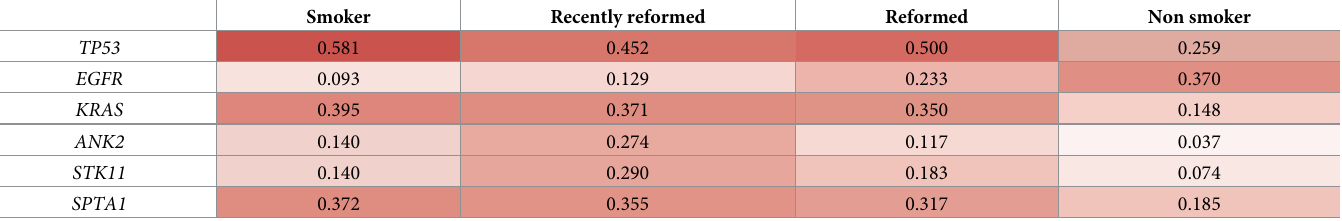
Table 7. Probabilities of source aberration with downstream target for lung cancer subtypes. For smoking history based categories of lung cancer, the heatmap repre- sents the probabilities that the indicated gene is a DNA-aberrant source gene with some downstream RNA-aberrant target. The sources are selected from the set of core genes for coverings of the given tissue; the selection criterion is that the probability of a DNA-aberration is high for at least one of the subtypes for that tissue. TP53 and KRAS are both more frequently DNA-aberrant (with some downstream RNA-aberrant target) among smokers than non-smokers whereas EGFR is a more aberrant source among non-smokers.